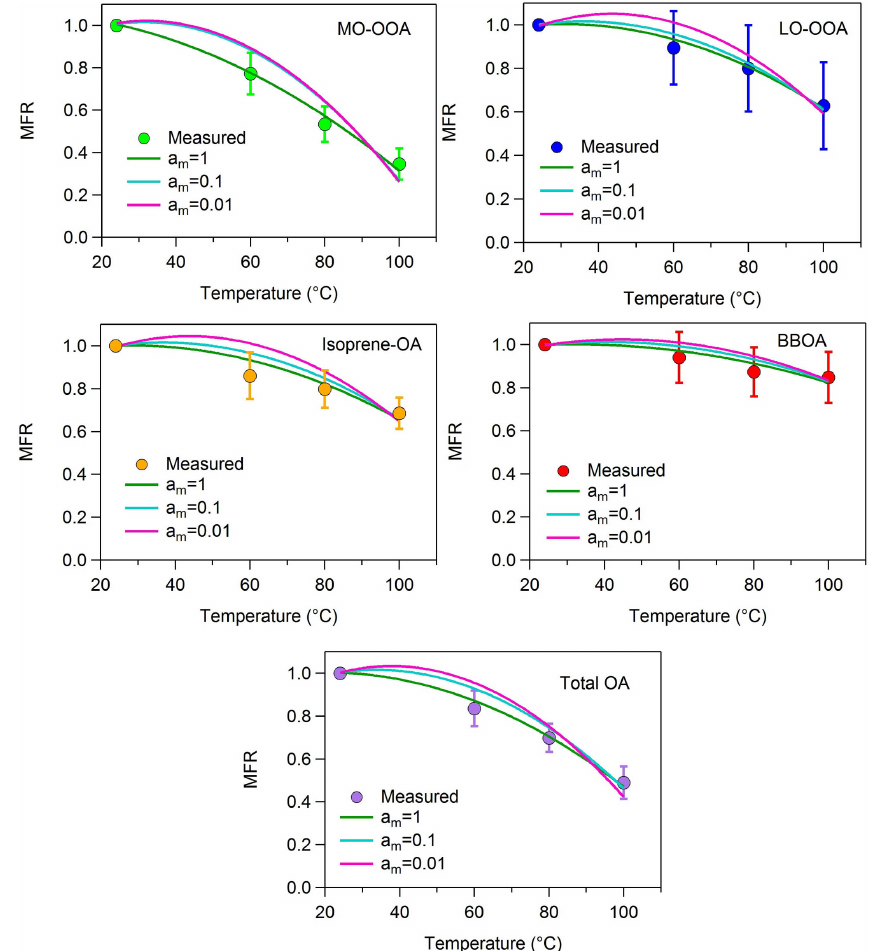
Figure A3. MFRs of the loss-corrected PMF OA factors and total OA. The circles denote the measurements with the 1 standard deviation of the mean, the green lines represent the best-predicted MFR for a m = 1 (base case), the cyan lines correspond to the best-predicted MFR for a m = 0 . 1 and the pink lines stand for the predicted MFR for a m = 0 .